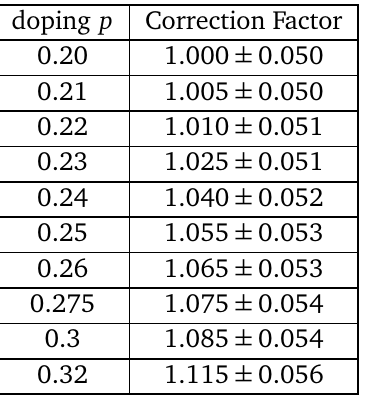
Table 7: Correction factor for the angle δ between k cates the spread of values providing a Fermi surface which fits within the width of the ARPES